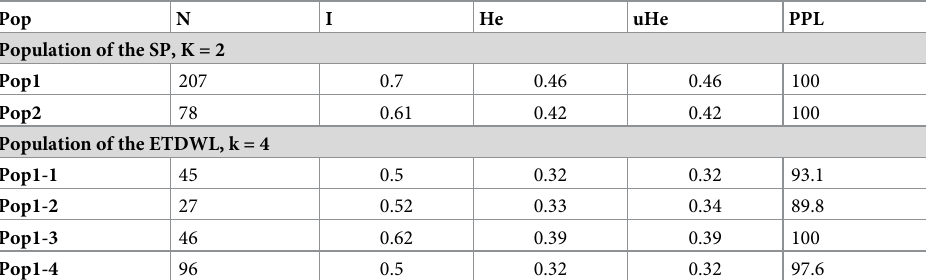
Table 2. Mean of different genetic indices parameters in each population.